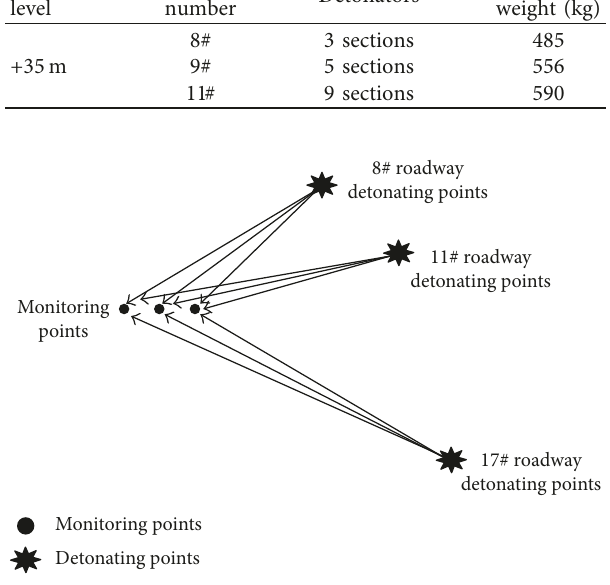
Figure 8: Multipoint differential blasting signal reception